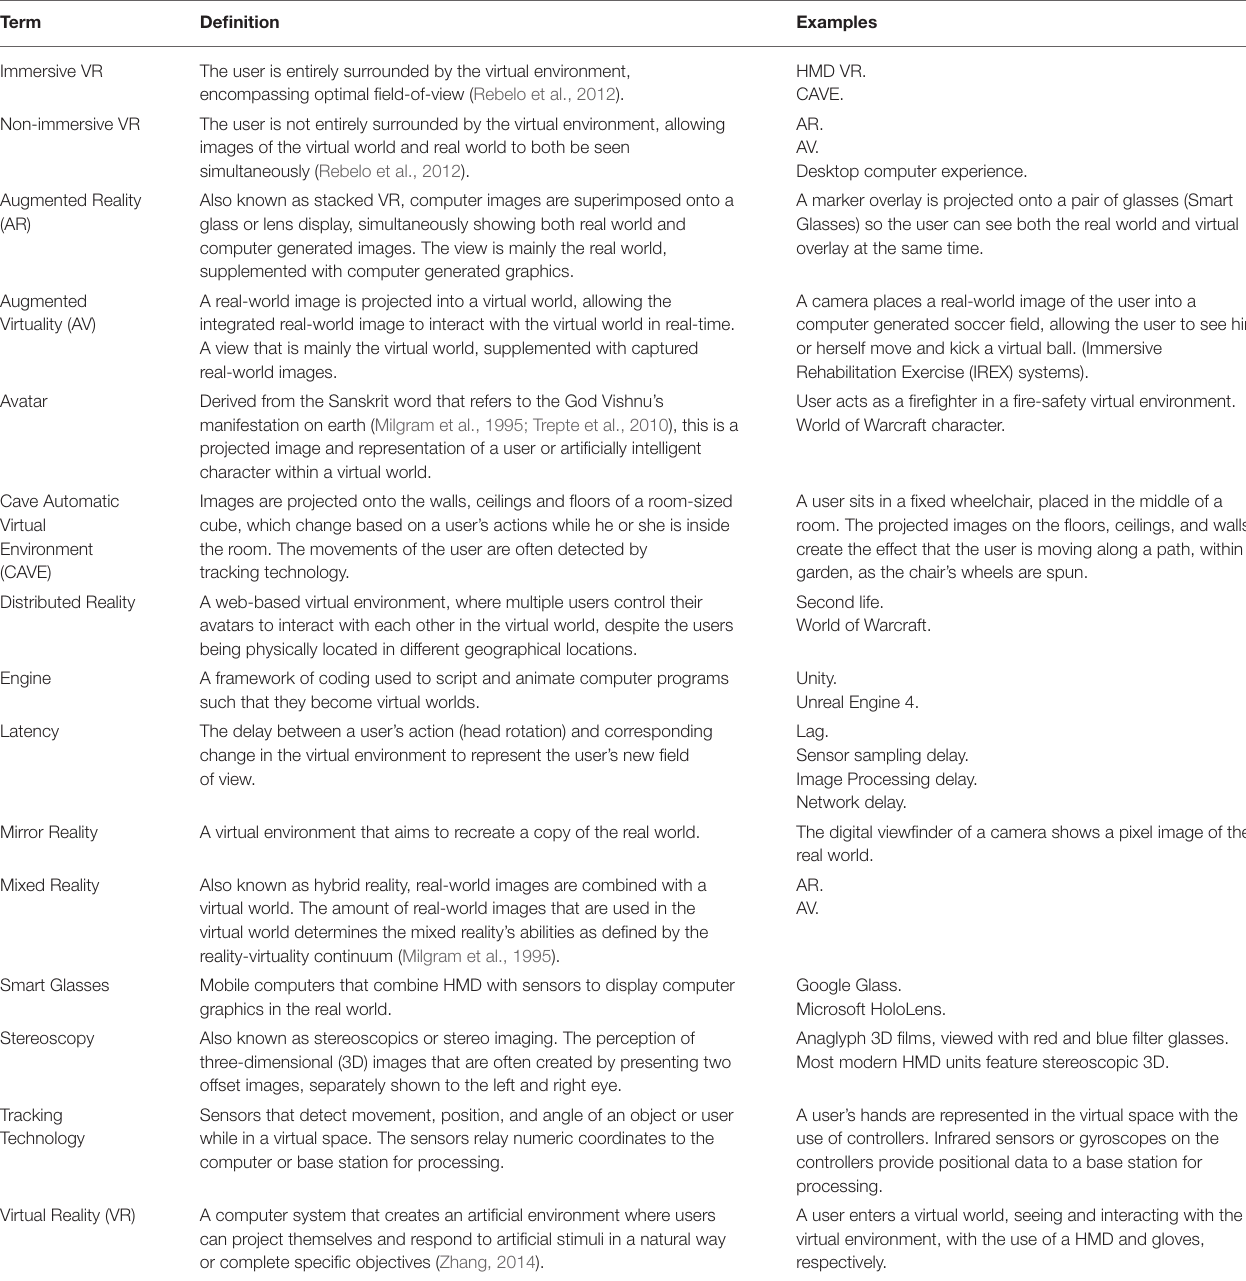
TABLE 1 | Glossary of common terms describing Virtual